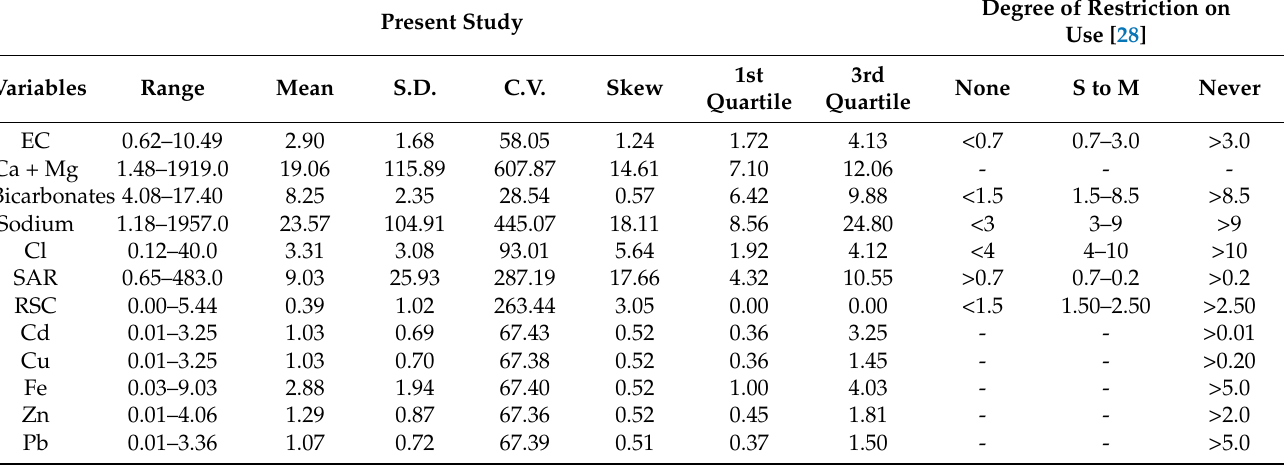
Table 2. Descriptive analysis of studied variable of the irrigation water of sampling sites with the permissible